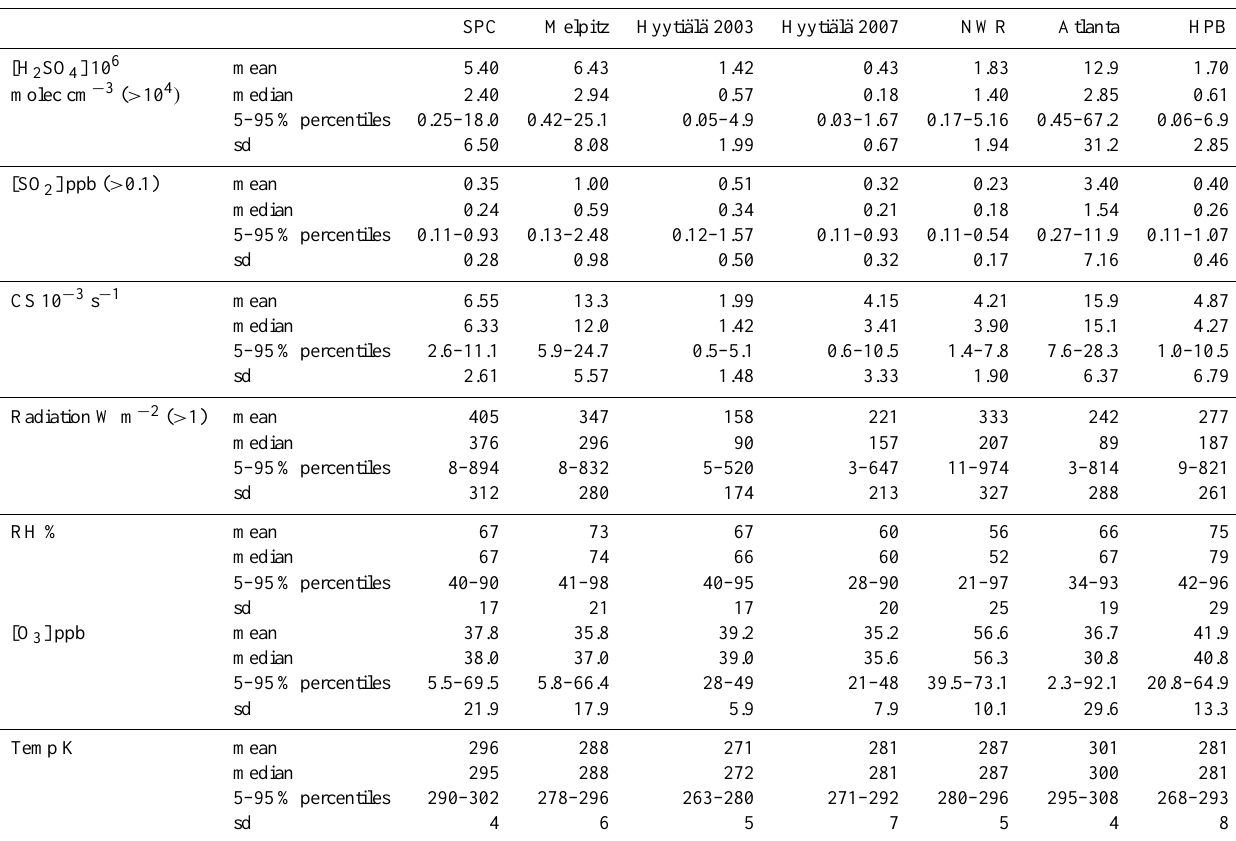
Table 2. Mean, median, 5–95% percentiles and standard deviation (sd) of 10min averages of the key variables of the study. Detection limits for [H 2 SO 4 ] and [SO 2 ] measurements are 10 4 molec cm − 3 and 0.1 ppb, respectively. In global radiation entries, only times when it was not completely dark are